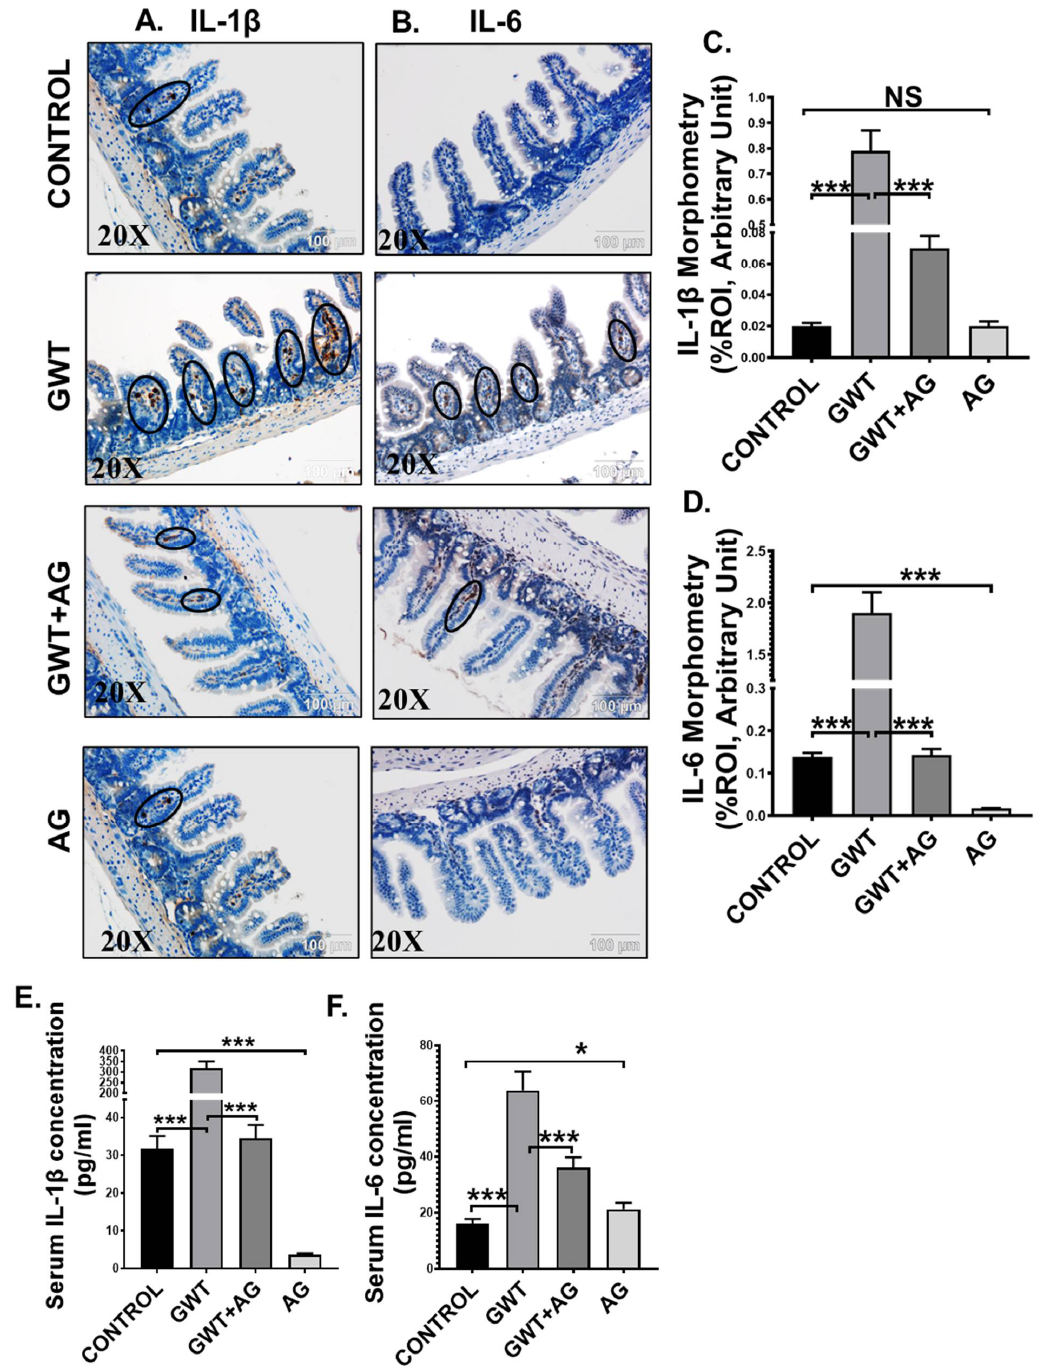
Figure 5. AG attenuates GW chemical-induced gut and systemic inflammation. Representative immunohistochemistry images of ( A ) IL-1β and ( B ) IL-6 immunoreactivity in the small intestine of CONTROL, GWT, GWT+AG, and AG mice groups. Images were captured in 20× magnification, and immunoreactivity was indicated by black arrows. Morphometric analysis (calculated as %ROI) of ( C ) IL-1β and ( D ) IL-6 immunoreactivity. Y -axis represents % positive immunoreactive area (% ROI) ( n = 3; mean value taken from three separate microscopic fields) (*** p < 0.001, NS: non-significant). The serum concentration (pg/mL) of both ( E ) IL-1β and ( F ) IL-6 levels were measured in CONTROL, GWT, GWT+AG, and AG mice groups and plotted as bar graphs. Data were represented as mean ± SEM and statistical significance was tested using unpaired t -test between the groups (* p < 0.05, ** p < 0.01, *** p < 0.001), followed by Bonferroni Dunn Post hoc